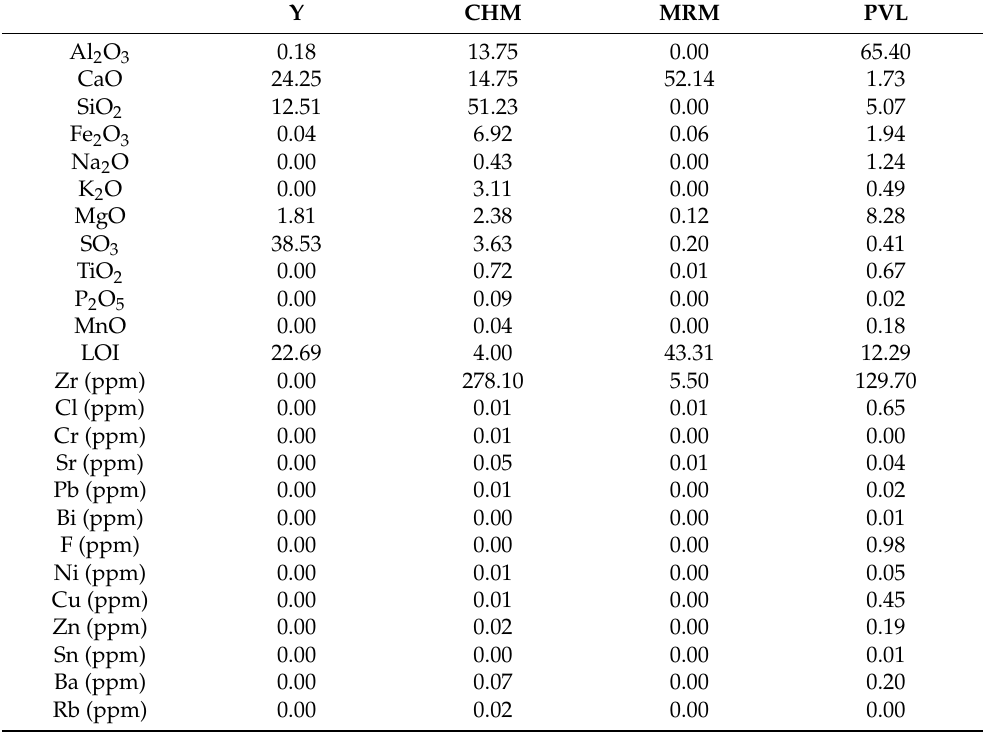
Table 3. Chemical composition (XRF, wt %) of the gypsum and the sample